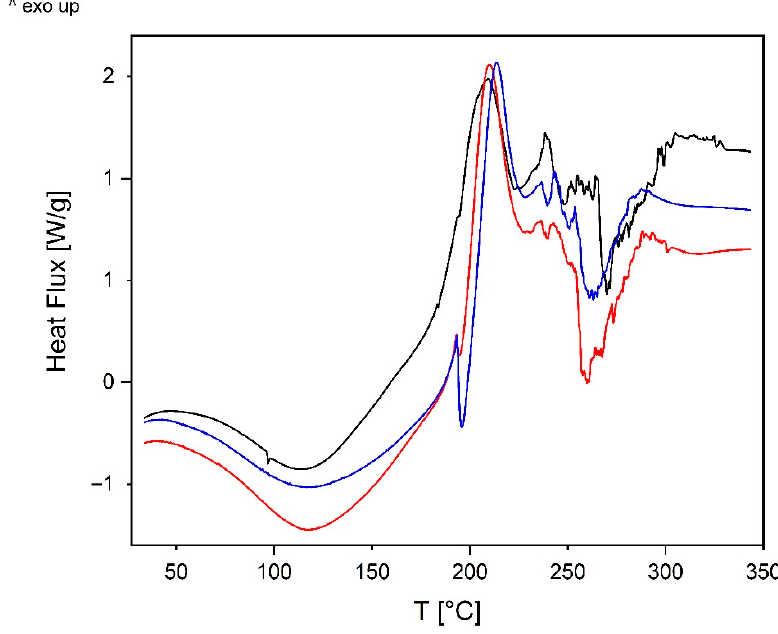
Figure 7. DSC chart in air: ALG (black line), ALG/Ag/GOX (blue line), ALG/Au/GOX (red line).